Question: Provide a publication-style caption for this figure.
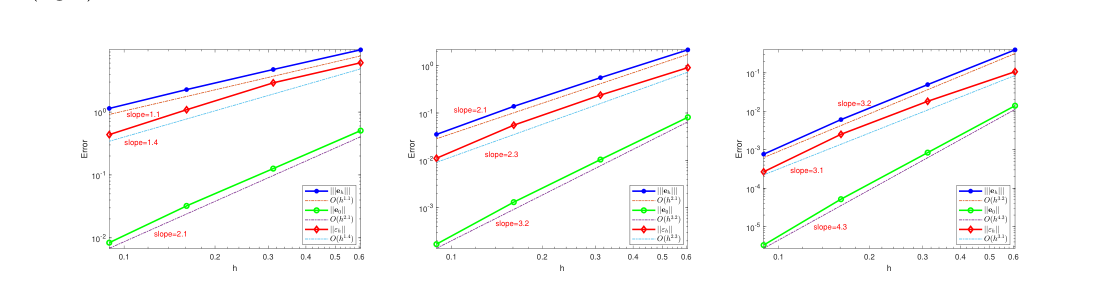
Answer: The numerical results for Example 7.2 on curved quadrilateral meshes with k = 1 (left), 2 (middle), 3 (right).